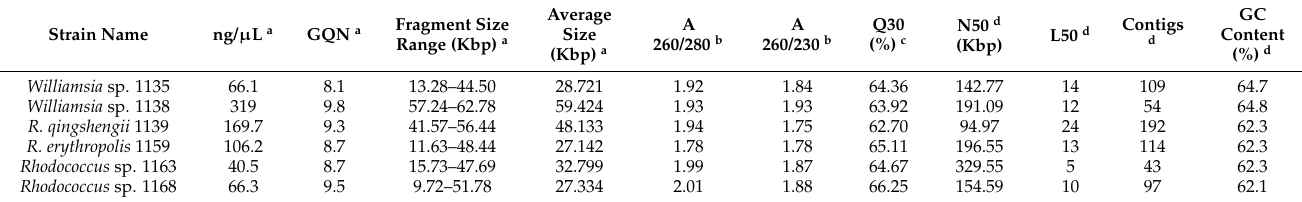
Table 2. Quality and quantity scores for gDNA obtained from large-scale (50 mL) cultures of six sub-Antarctic